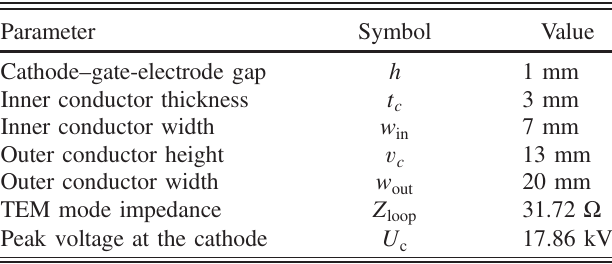
TABLE I. Parameters of the stripline-loop in Fig.